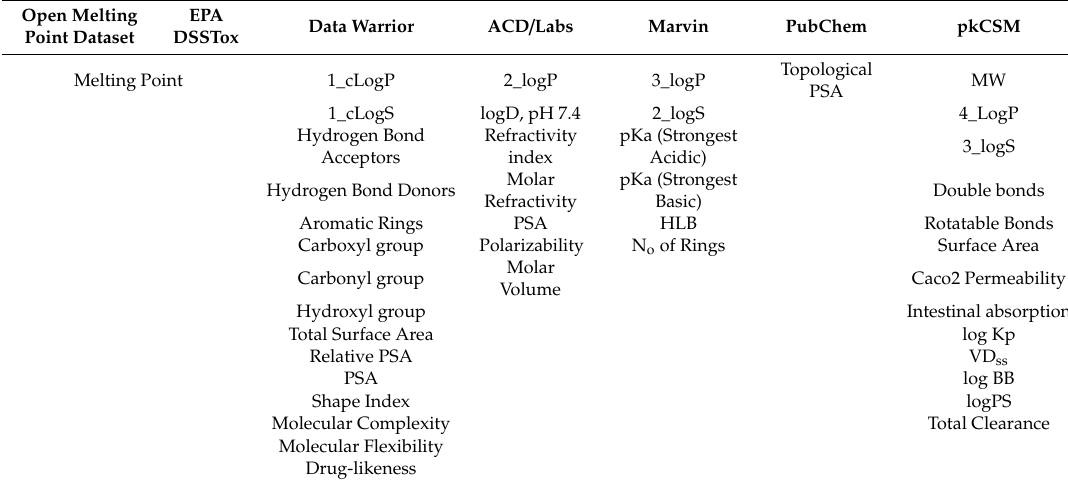
Table 1. X Descriptors of